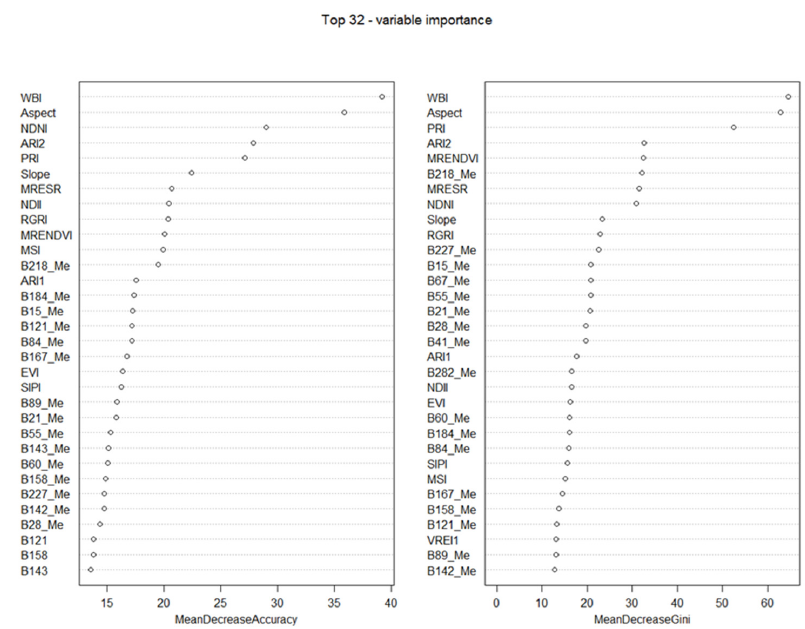
Figure 4. The importance ranking results of random forest characteristic variables.